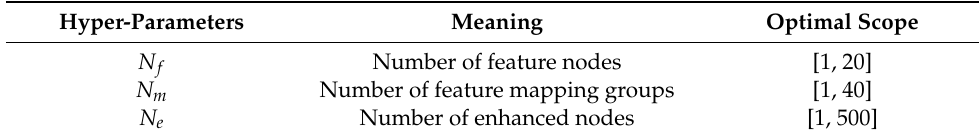
Table 2. The optimization range of hyper-parameter combination.